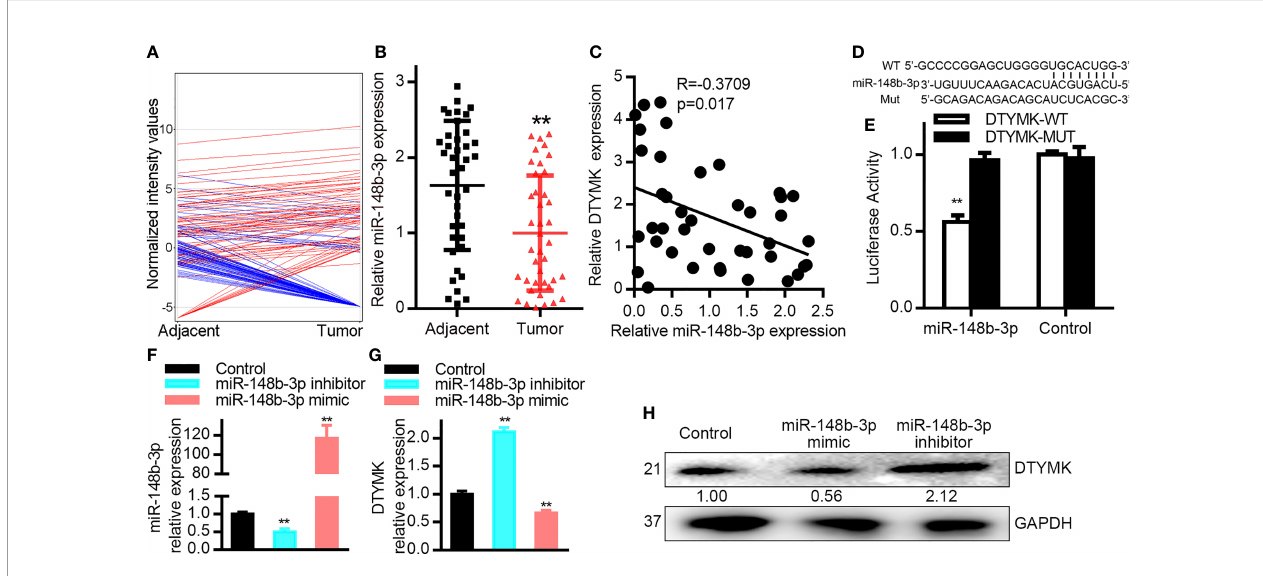
FIGURE 3 | MiR-148b-3p targets DTYMK in HCC cells. (A) miRNA expression pro fi les were compared in tumor and paracancerous tissues via Agilent Human miRNA microarray. (B) MiR-148b-3p expression was assessed via qRT-PCR in HCC tumor and paracancerous tissues (n = 40). (C) Correlations between the expression of DTYMK and miR-148b-3p in HCC patient samples (n = 40 samples). p = 0.017, R = − 0.3709; Spearman correlation analysis. (D) Schematic of the putative miR-148b-3p binding site in the DTYMK 3 ’ -UTR. WT or MUT DTYMK 3 ’ -UTR constructs were cloned into the pGL6-miR luciferase reporter vector. (E) Co- transfection of Hep3B cells with miR-148b-3p and the WT DTYMK 3 ’ - UTR vector was associated with reduced luciferase activity, whereas the activity of the MUT vector was not affected. As a control, Hep3B cells were transfected with the luciferase reporters and a negative control miRNA, or with vectors alone. (F) MiR-148b- 3p expression levels in Hep3B cells transfected with a miR-148b-3p inhibitor or mimic. (G, H) DTYMK mRNA and protein levels in cells treated as in (F) . Data are means ± SD. ** p < 0.01; Student ’ s t-tests and Spearman ’ s correlation